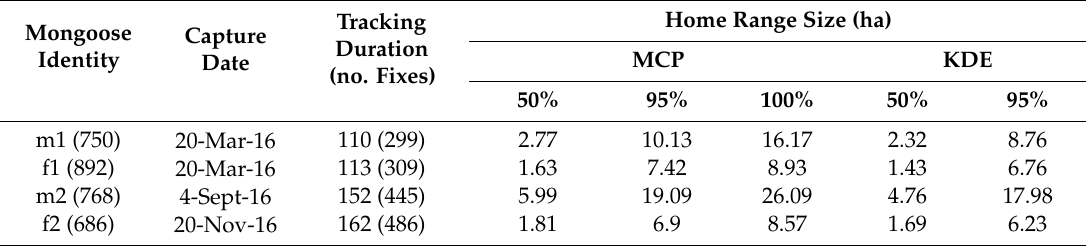
Table 3. Home range sizes from MCP and KDE estimates of individual male (m) and female (f) yellow mongoose (mass in grams), and tracking duration, in days, in the Meyersdal estate.